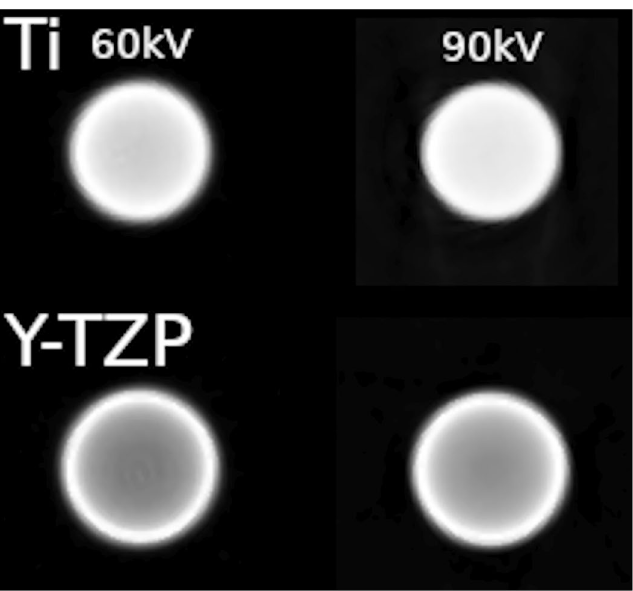
Figure 5. Slices through the DICOM CBCT-reconstruction of the implant samples for both materials and minimum (60 kVp) versus maximum (90 kVp) beam energy. Beam hardening is clearly visible in the center of the homogenouos implant as significantly darker gray values. This is particularly emphasized in the Y-TZP reconstructions (lower row).